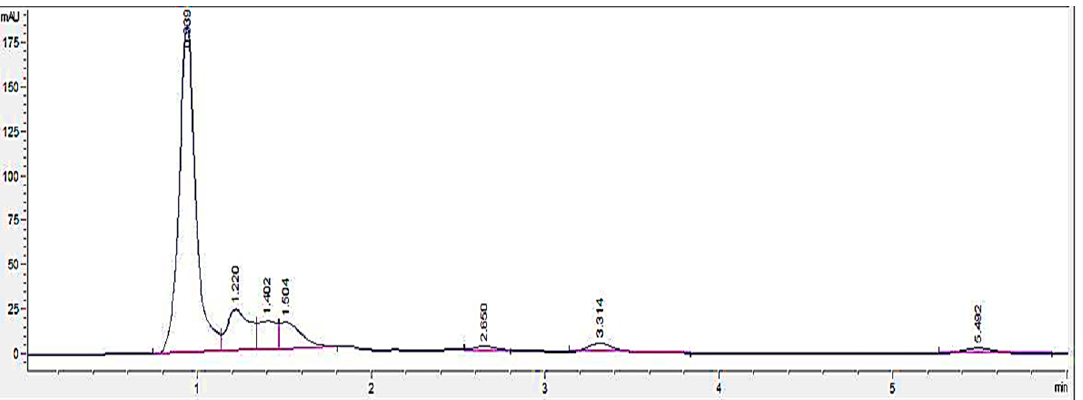
Figure 2. HPLC chromatogram profile for Leucaena leucocephala (LL) extract. In total, 7 peaks were revealed at different RTs between 0 to 6 min, with the highest peak at 0.939 min acquiring 184.66 mAU. Key: y -axis: mAU, milli-absorbance unit; x -axis: min, minutes.